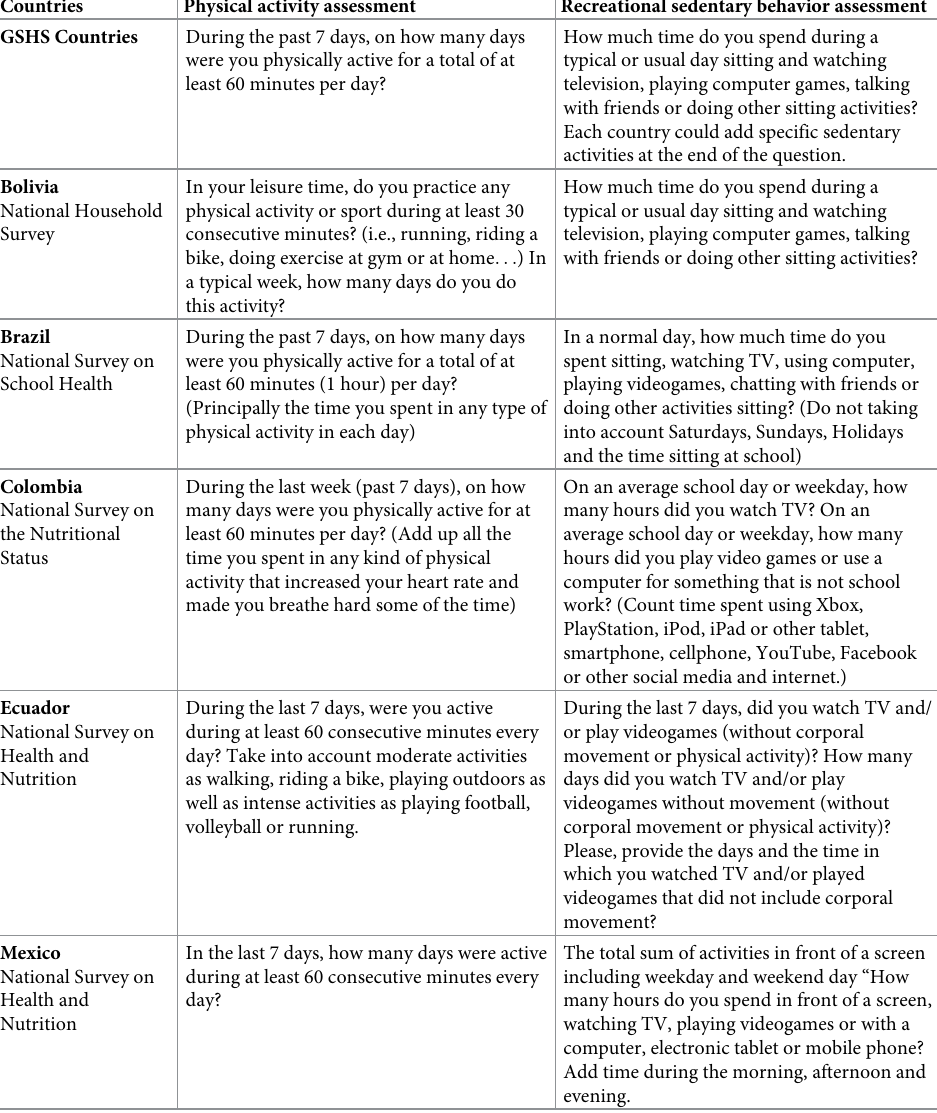
Table 1. Questions used to assess physical activity and recreational sedentary behavior in the different surveys